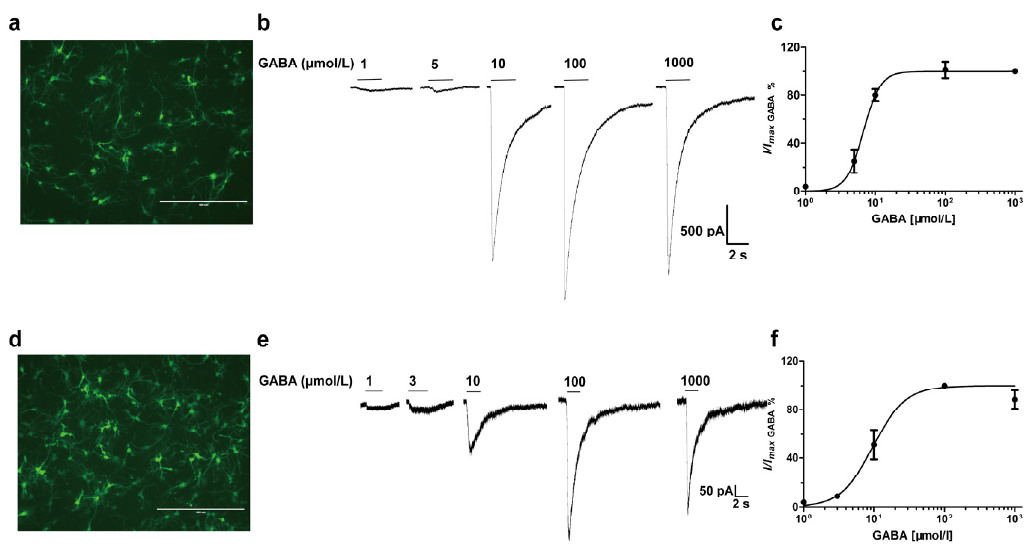
Figure 5. GABA concentration-relationship on hippocampal and cortical neurons. GABA (1–1000 µ mol / L) was applied to acutely dissociated hippocampal or cortical neurons at 5 min intervals. ( a , d ) Immunofluorescence staining of hippocampal ( a ) and cortical neurons ( d ) with 160 kD neurofilament medium markers. ( b , e ) The current traces of different GABA concentrations from single cortical and hippocampal neuron. ( c , f ) GABA concentration-response curves in hippocampal and cortical neurons. Each point represents the normalized mean peak currents from 3 to 4 cells.